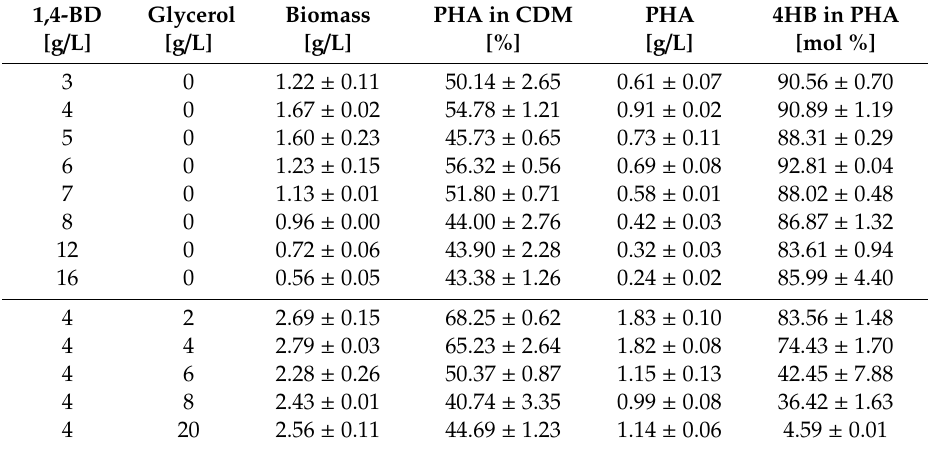
Table 5. E ff ect of initial concentration of 1,4-butanediol and glycerol on production of P(3HB- co -4HB) by Aneurinibacillus sp.